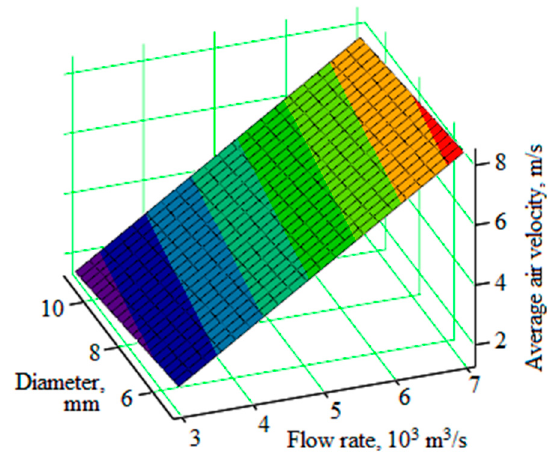
Figure 6. The linearized dependence of the average velocity on the diameter and flow rate.